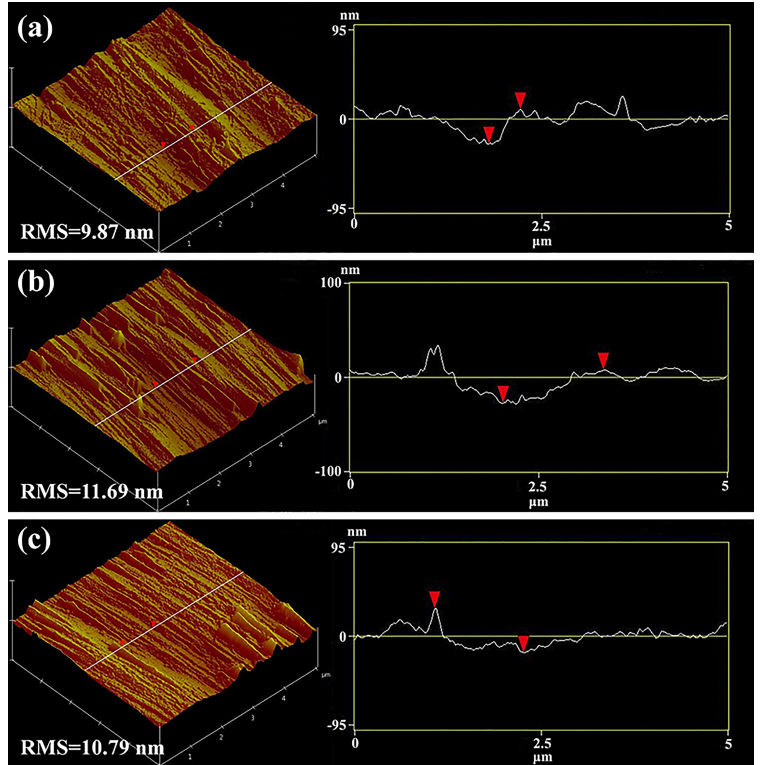
Figure 5. AFM 3D-microtopography and height profiles along the white line of the (1122) GaN templates with different superlattice structures: ( a ) Sample A; ( b ) Sample B; ( c ) Sample